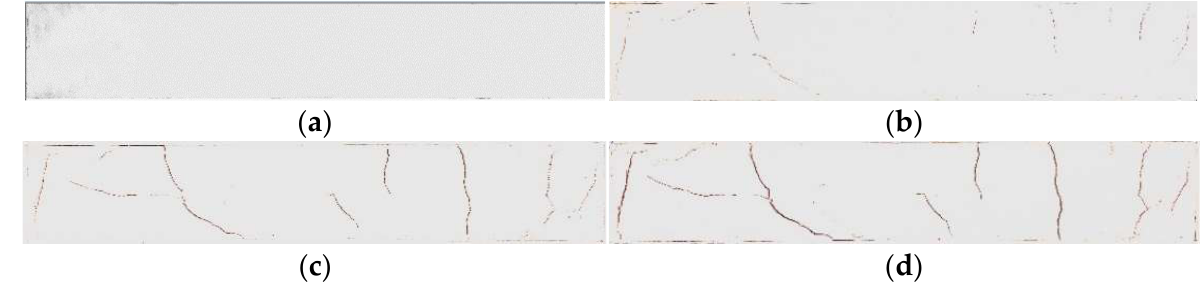
Figure 5. Cracking of specimens with a size of 60 cm × 10 cm × 2 cm. ( a ) initial stage; ( b ) crack development stage; ( c ) crack development stage; ( d ) final crack morphology.